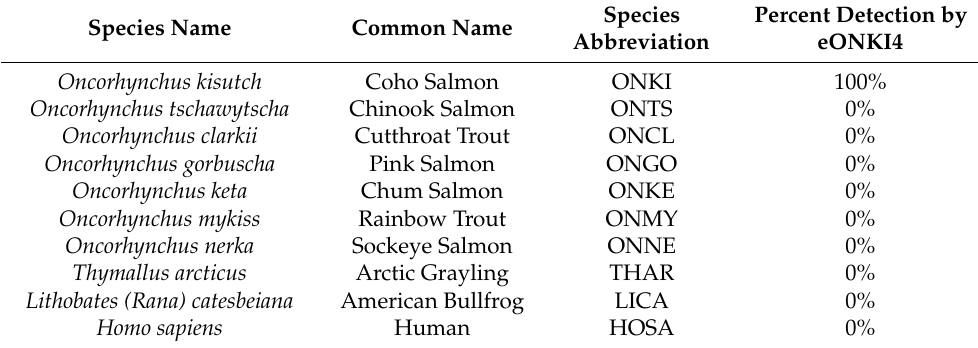
Table 2. Names and abbreviations of species used for eONKI4 coho salmon eDNA assay validation. All species listed were validated with 25 technical